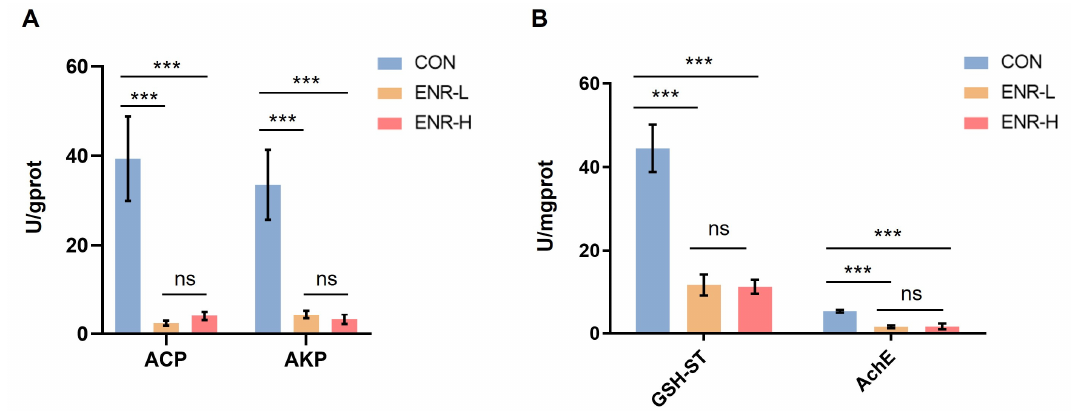
Figure 6. Effects of different enrofloxacin residues on enzyme activity in the hepatopancreases of E. sinensis specimens. CON represents the control group, ENR-L represents the low-concentration en- rofloxacin residue group, and ENR-H represents the high-concentration enrofloxacin residue group. *** p < 0.001. ( A ) Pollution impact indicators, acid phosphatase (ACP) and alkaline phosphatase (AKP), indicating the impact of low- and high-concentration enrofloxacin residues on the immune defense of E. sinensis . ( B ) Metabolic process indicators, glutathione sulfotransferase (GSH-ST) and acetylcholinesterase (AchE), indicating the impact of low- and high-concentration enrofloxacin res- idues on metabolic processes of the liver and pancreas in E. sinensis . The meaning of “ns” in figure is “no significance”. 4. Discussion Our results indicated that exposure to low or high doses of enrofloxacin resulted in hepatopancreatic damage in E. sinensis . The RNA sequencing results demonstrated that enrofloxacin-induced hepatopancreatic damage was closely related to disorders of the metabolic processes and the immune system. Enrofloxacin, a third-generation fluoroquinolone antibacterial drug, is commonly used to treat bacterial infections in crab breeding; however, the side effects of this antimi- crobial treatment deserve attention. For example, the expression level of key genes and enzymes in the hepatopancreases of the E. sinensis specimens treated with enrofloxacin were disturbed [18]. The enrofloxacin biotransformation product, ciprofloxacin, at low and high doses affected the expression of many genes in the hepatopancreases of the E.